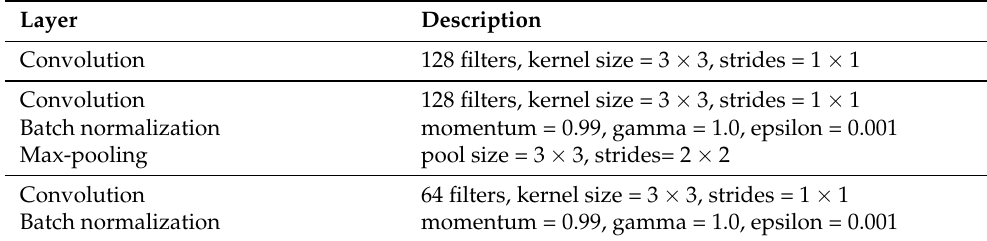
Table 1. Proposed convolutional neural network